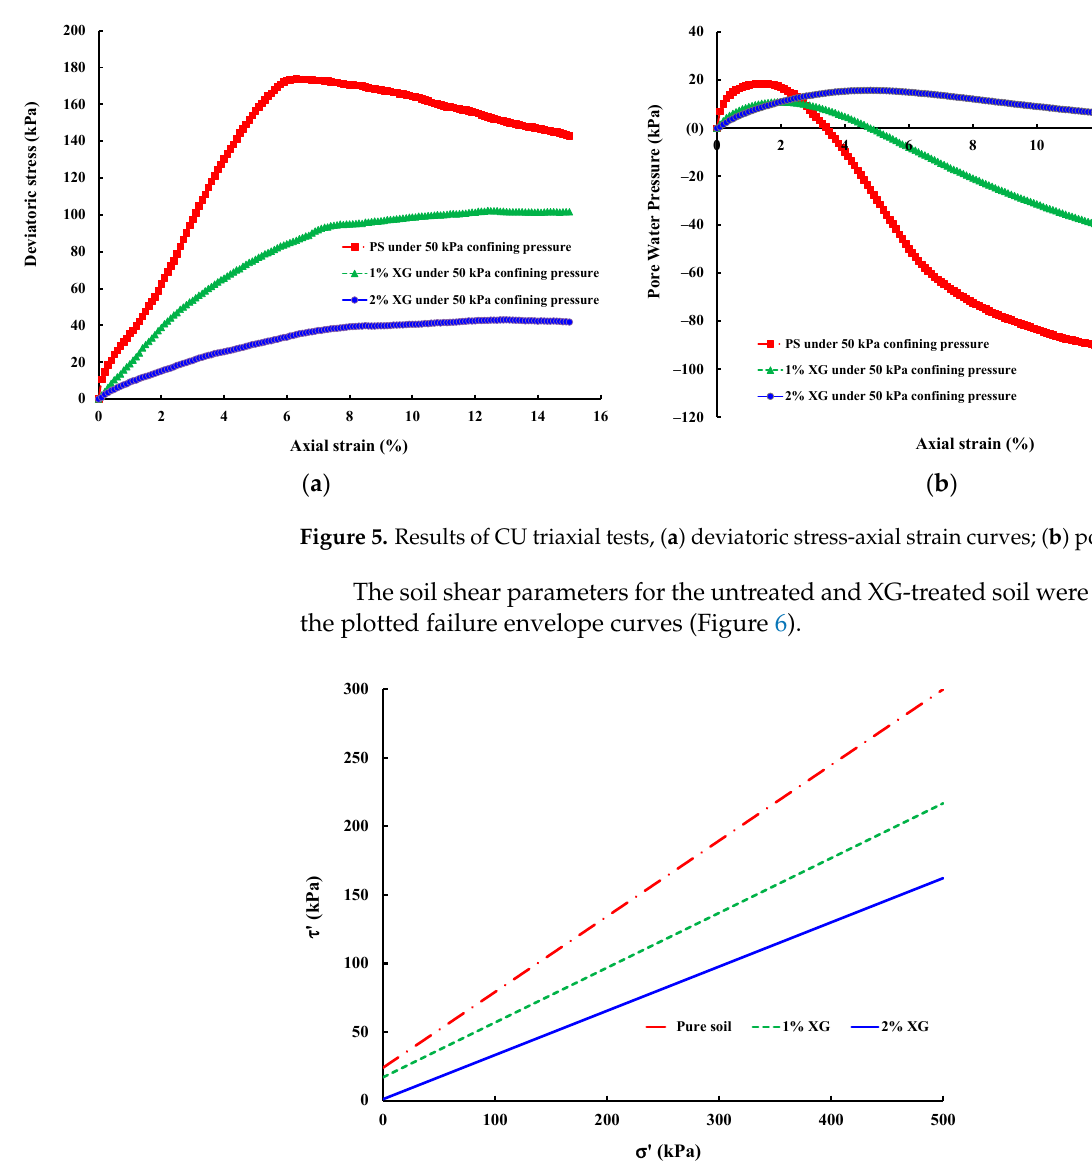
Table 2. Effective friction angle and cohesion of pure soil and XG-treated soil. Soil Reference Effective Cohesion, c ′ (kPa) Effective Internal Friction Angle, ϕ′ (°) Pure soil